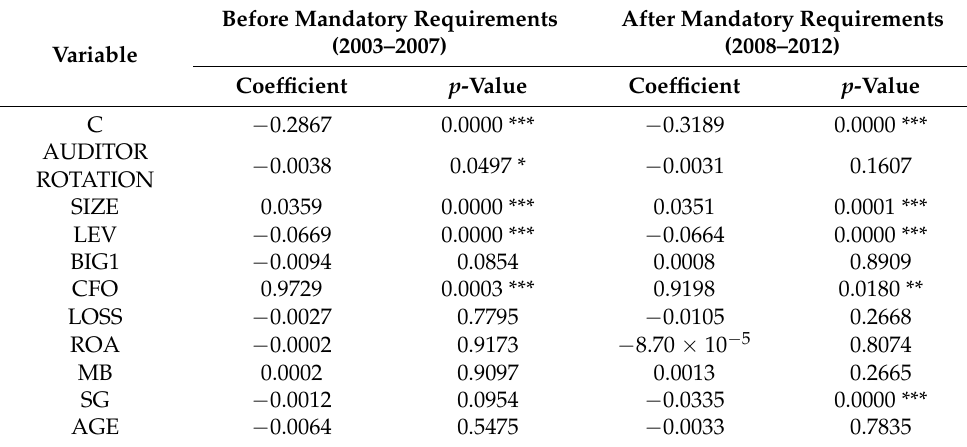
Table 9. The results of the second